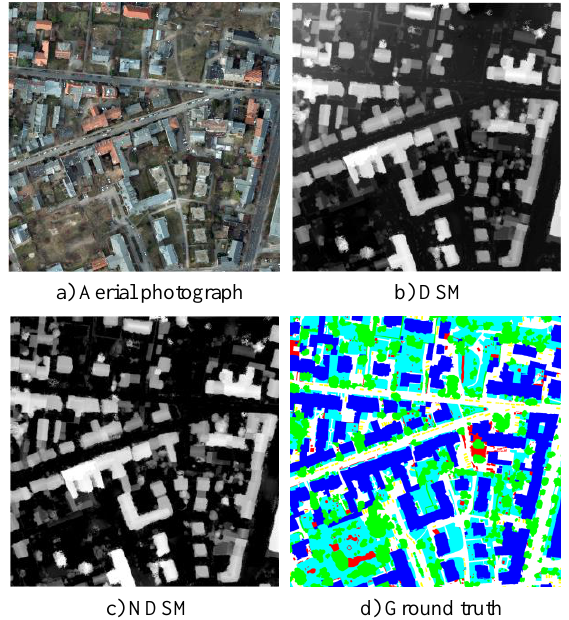
Figure 1. The Potsdam dataset contain: a) true colour aerial image (RGB and IR), b) DSM, c) NDSM and d) corresponding ground truth